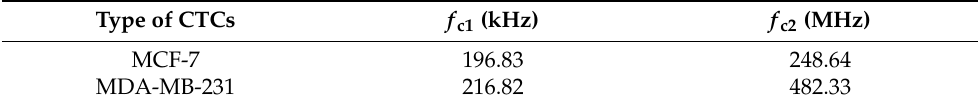
Table 1. Crossover frequencies ( f c ) of MCF-7 and MDA-MB-231. The calculations were performed for 0.1 PBS with an electrical conductivity of σ m = 0.19